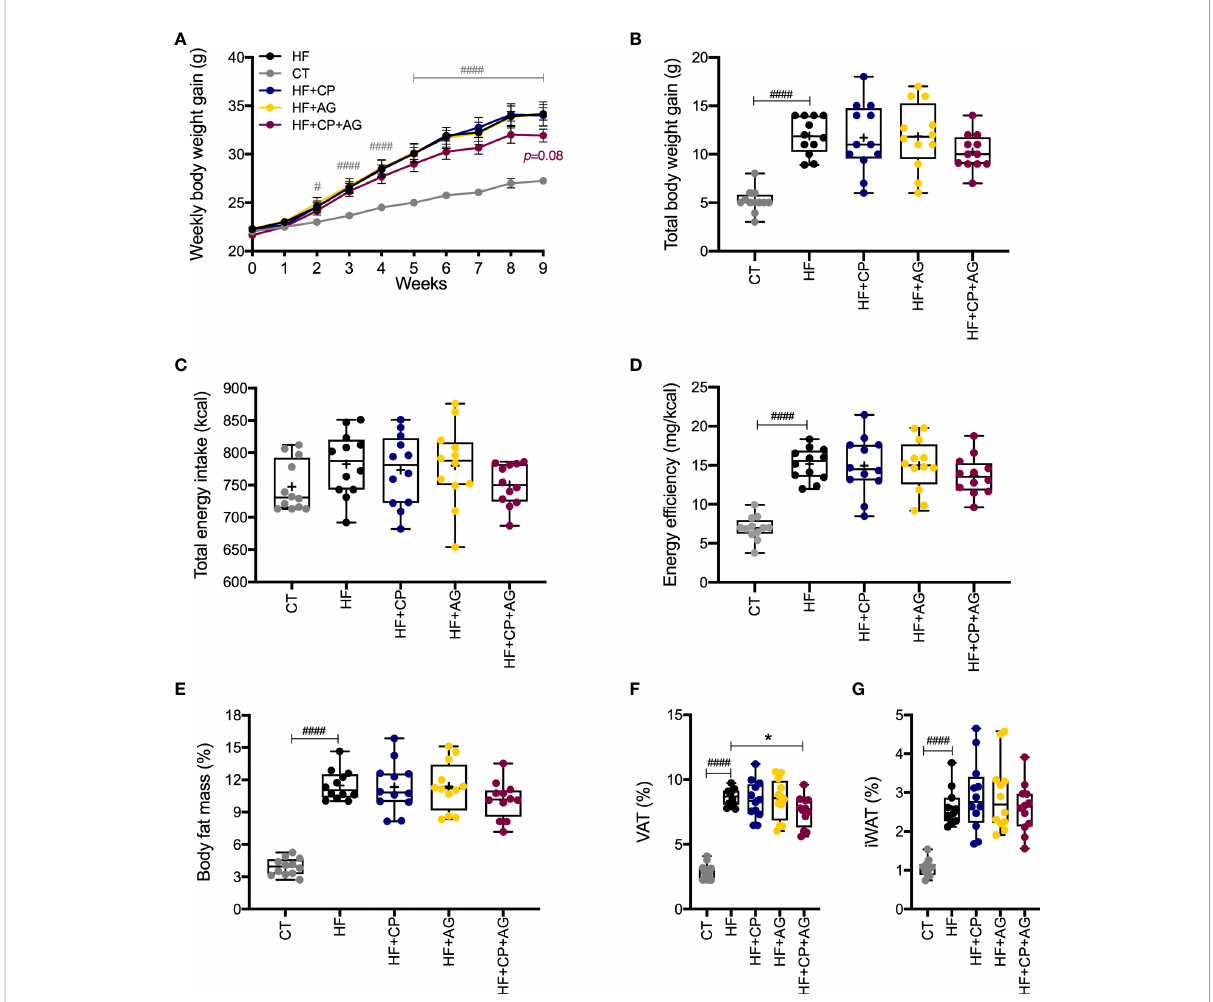
FIGURE 1 Cranberry polyphenol + agavin effects in body weight gain and body fat mass in HFHS-fed mice. (A) Weekly body weight gain expressed in grams gained by male C57BL/6 mice consuming the indicated diets for the 9-week intervention period. (B) Total body weight gain in grams at the end of week 9. (C) Total energy intake in kilocalories (kcal). (D) Energy ef fi ciency corresponding to the ratio of body weight in milligrams (mg) to energy intake in kilocalories (mg/kcal). (E) Percentage (%) of body fat mass expressed relative to body weight at 9 weeks. (F) Percentage (%) of visceral adipose tissue (VAT%), represented by the sum of retroperitoneal white adipose tissue (rpWAT) + epididymal white adipose tissue (eWAT). (G) Percentage of inguinal white adipose tissue (IWAT%). CT — chow diet. HF — high-fat high-sugar diet. HF+CP — high-fat high-sugar diet and cranberry polyphenols. HF+AG — high-fat high-sugar diet and agavins. HF+CP+AG — high-fat high-sugar diet and the combination of CP+AG. Two-way repeated-measure ANOVA (RM two-way ANOVA) with Dunnett ’ s multiple-comparison test ( post-hoc test) was employed to calculate the signi fi cance between groups at different time points. One-way ANOVA with a Dunnett ’ s multiple-comparison test ( post-hoc test) was employed to calculate the signi fi cance of the differences between groups. Values are expressed as the mean ± SEM (n = 12). Boxplots represent the distribution of data with the mean represented by the mark “ + ” within the boxes, the median represented by the dark horizontal line and interquartile range by the box, *p < 0.05 as compared to the HFHS-control group. # p < 0.05; ### p < 0.001. Chow-control group versus HFHS-control